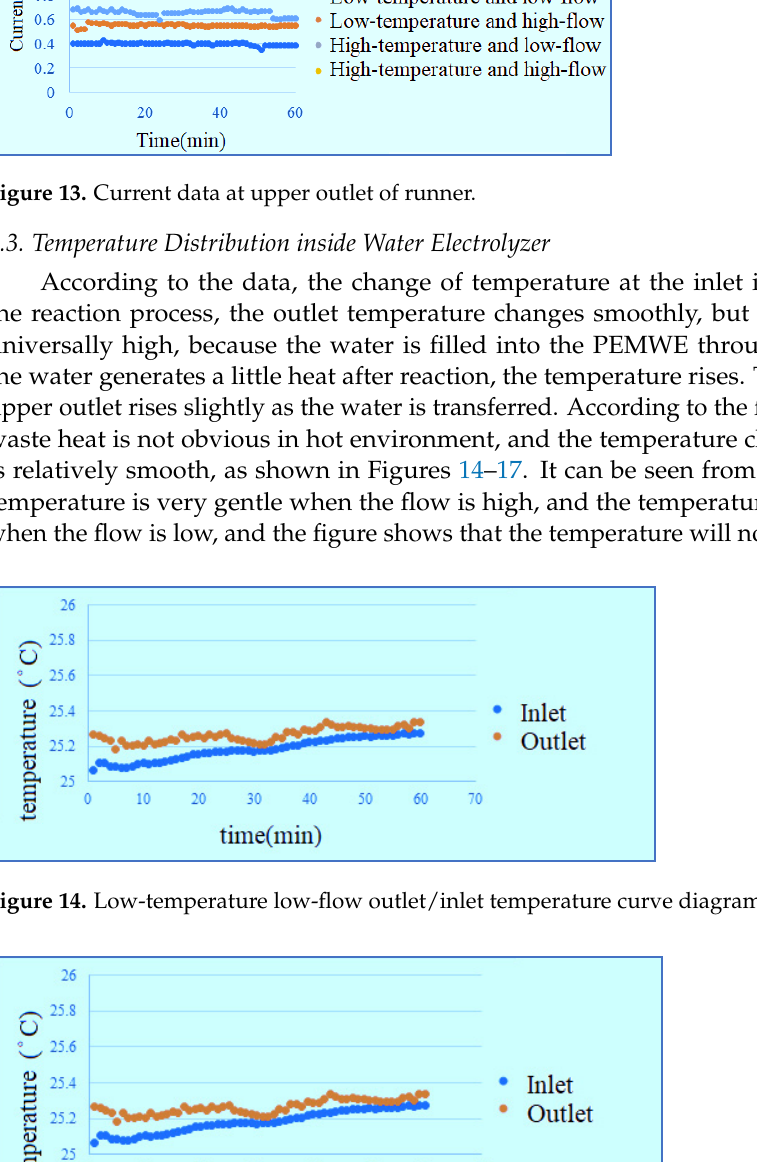
Figure 12. Current data at lower inlet of runner.